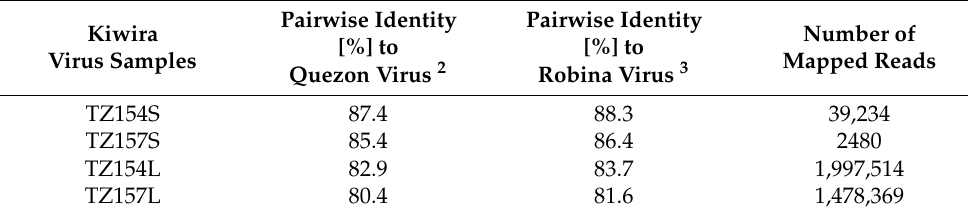
Table 3. Pairwise identities between sequences from Tanzania and their closest relatives, Quezon virus and Robina virus [%] 1 .